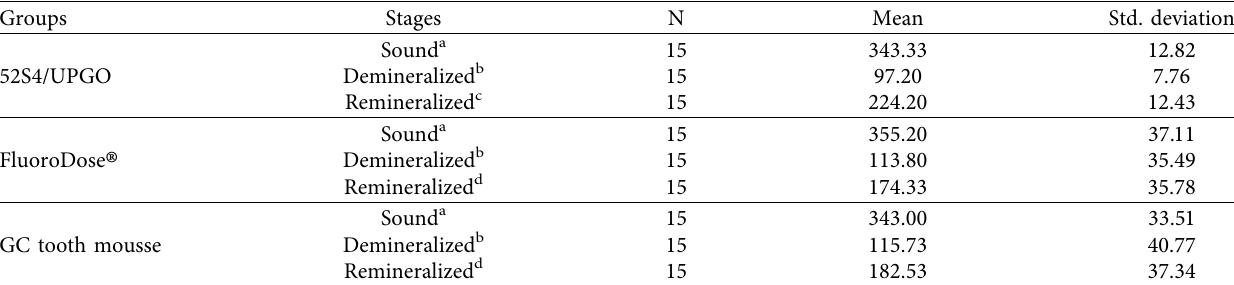
Table 3: Means and standard deviation of microhardness values for each group (at sound, demineralized, and remineralized stages).